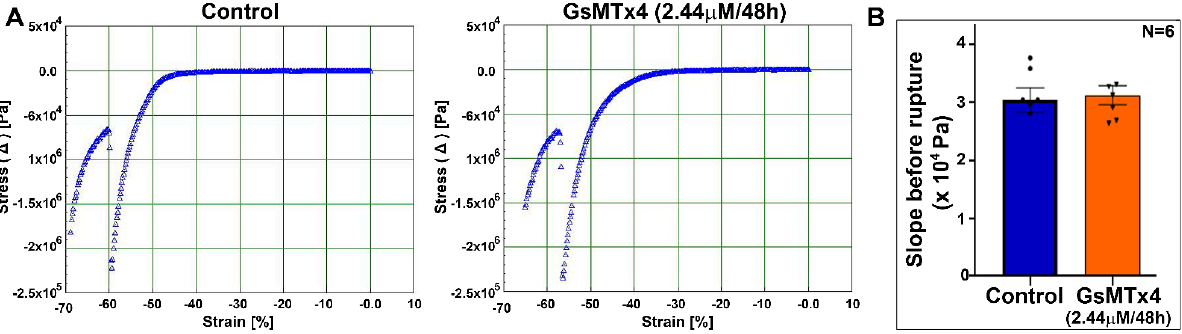
Figure 8. The mouse lens maintains normal tensile properties under Piezo1 channel inhibition. ( A ) A representative microstrain analyzer generated stress/strain tracings of mouse lenses from the con- trol and GsMTx4-treated groups. ( B ) Changes in Young’s modulus calculated from the lens prerup- ture stress/strain slopes were not different between the GsMTx4-treated and control lenses. Values are denoted as Mean ± SEM.